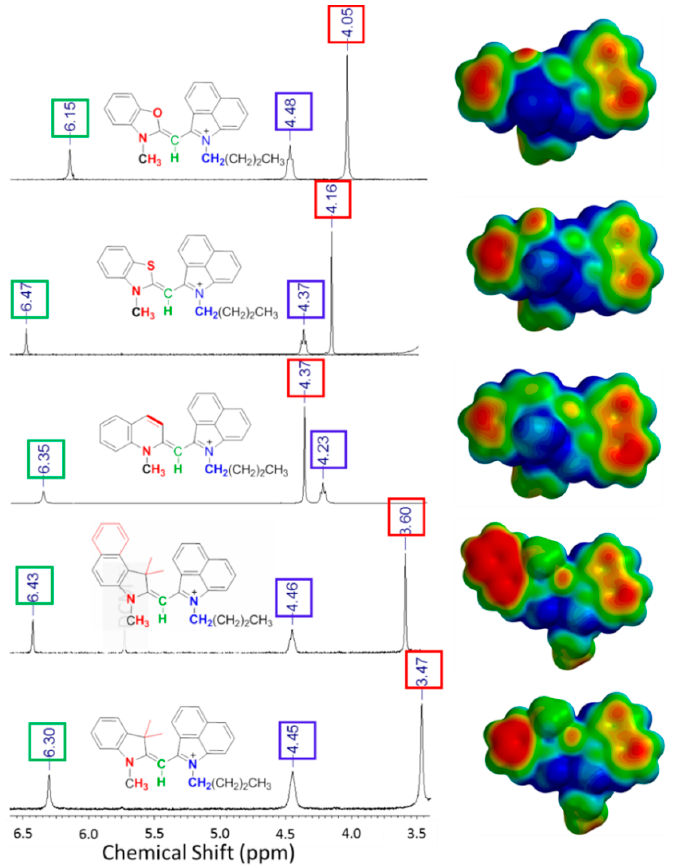
Figure 6. 1 H-NMR shift of meso -proton in DMSO- d 6 at 25 °C, Calculated EMP on the right. Table 2. λ max , NMR shifts, and computational charges of monomethine cyanine dyes. Heterocycle λ abs λ abs Charge of Methine Included in (nm) (nm) Carbon Monomethine Dye exp. calc.